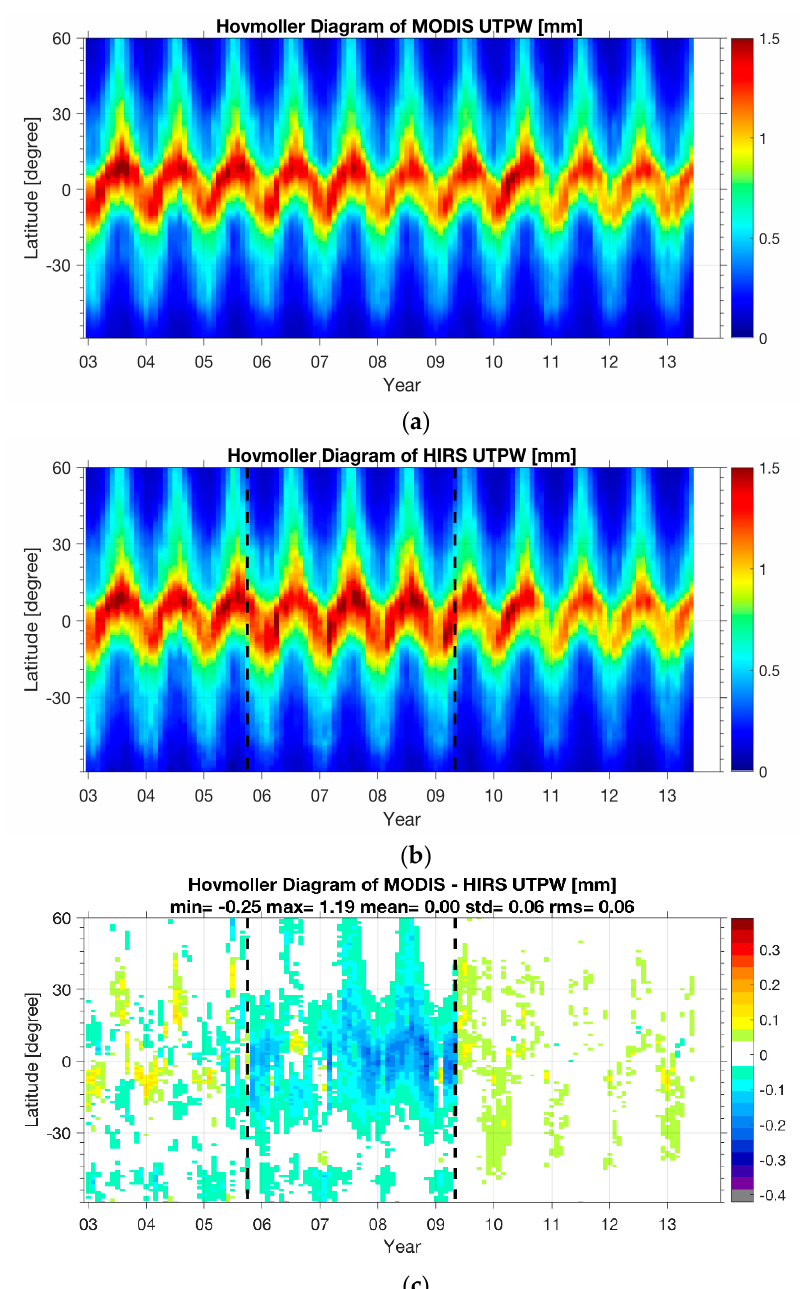
Figure 2. Hovmoller plot of Upper Tropospheric Precipitable Water Vapor (UTPW) in 2003–2014 for Aqua MODIS ( a ) and NOAA-16, -18, and -19 HIRS ( b ) along with the MODIS minus HIRS difference ( c ). Vertical dashed lines indicate the time when the operational satellite changed from NOAA-16 to NOAA-18 in November 2005 and from NOAA-18 to NOAA-19 in June 2009. Zonal mean values of MODIS and HIRS, and their differences (MODIS-HIRS) for 1 degree latitude bands for TPW and UTPW, are shown in Figures 5 and 6. MODIS and HIRS TPW are within 2 mm for all latitudes; MODIS is wetter than HIRS from 20 ◦ S to 20 ◦ N but drier from 35 ◦ to 55 ◦ N (see Figure 5). Overall agreement is better than 5% for all zones between 60 ◦ S and 60 ◦ N. UTPW latitude mean values agree within 0.07 mm with MODIS drier in the tropics (Figure